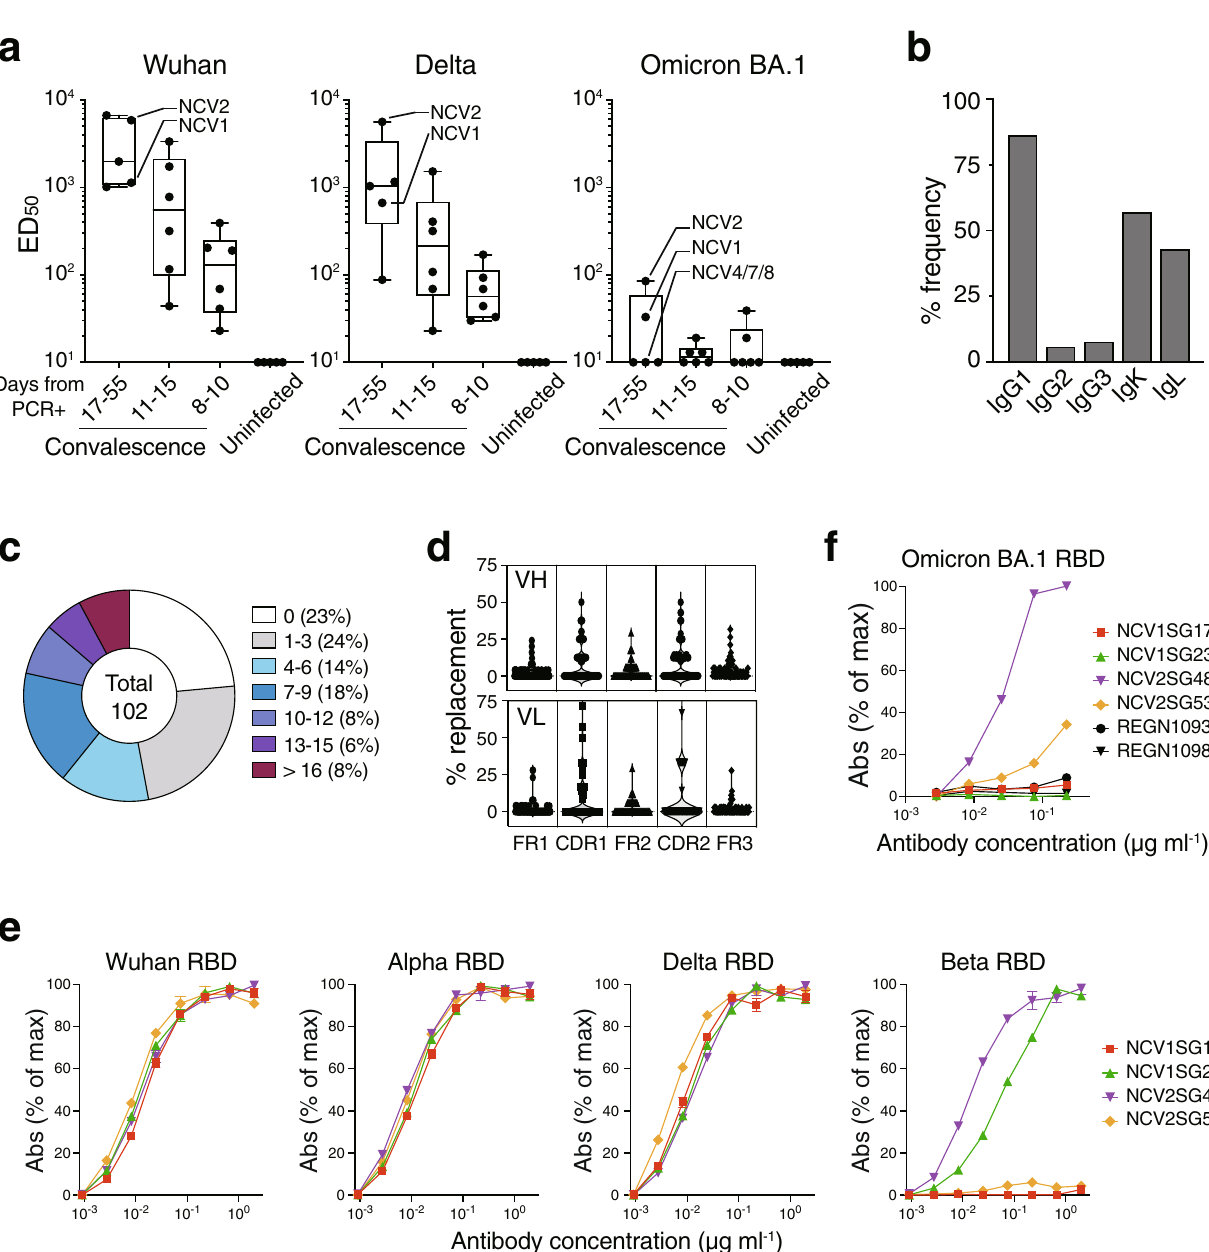
Fig. 1 Isolation of broadly reacting mAbs from convalescence patients of early SARS-CoV-2 strain. a Serum neutralizing antibody titers (ED 50 ) against SARS-CoV-2 pseudovirus of Wuhan, Delta, or Omicron BA.1. Serum from early COVID-19 convalescent individuals infected fi rst time with B.1.1 (D614G) strain without vaccination or uninfected/non-vaccinated healthy donors were evaluated. COVID-19 convalescent individuals ( n = 17) are subgrouped by hospitalization period from PCR results. Subjects used for mAb production (NCV1, 2, 4, 7, 8) were indicated. Each box indicates the median and 25 – 75 percentile with min to max whiskers. b – d Sequence of generated 102 mAbs from NCV1, 2, 4, 7, and 8 are analyzed. b Frequency of IgG subclasses and light chain isotypes. c Distribution of VH and VL amino acid mutation numbers. d Percentages of amino acid replacement in FR and CDR region of VH and VL. FR, framework region; CDR, complementarity-determining region. e , f Binding properties of indicated mAbs against RBDs of SARS-CoV-2 Wuhan-Hu-1 or indicated variants. Data are mean ± SD of technical triplicates. Abs, NCV1SG17, NCV1SG23, NCV2SG48, and NCV2SG53, all of